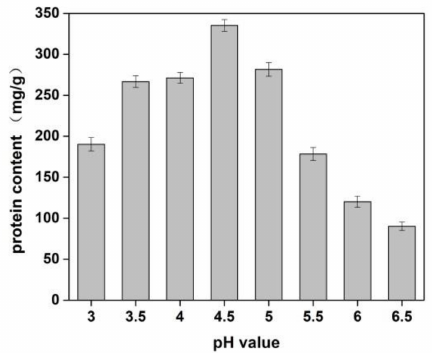
Figure 1. Effects of pH value on the yield of proteins of Cornus officinalis. Experimental conditions: